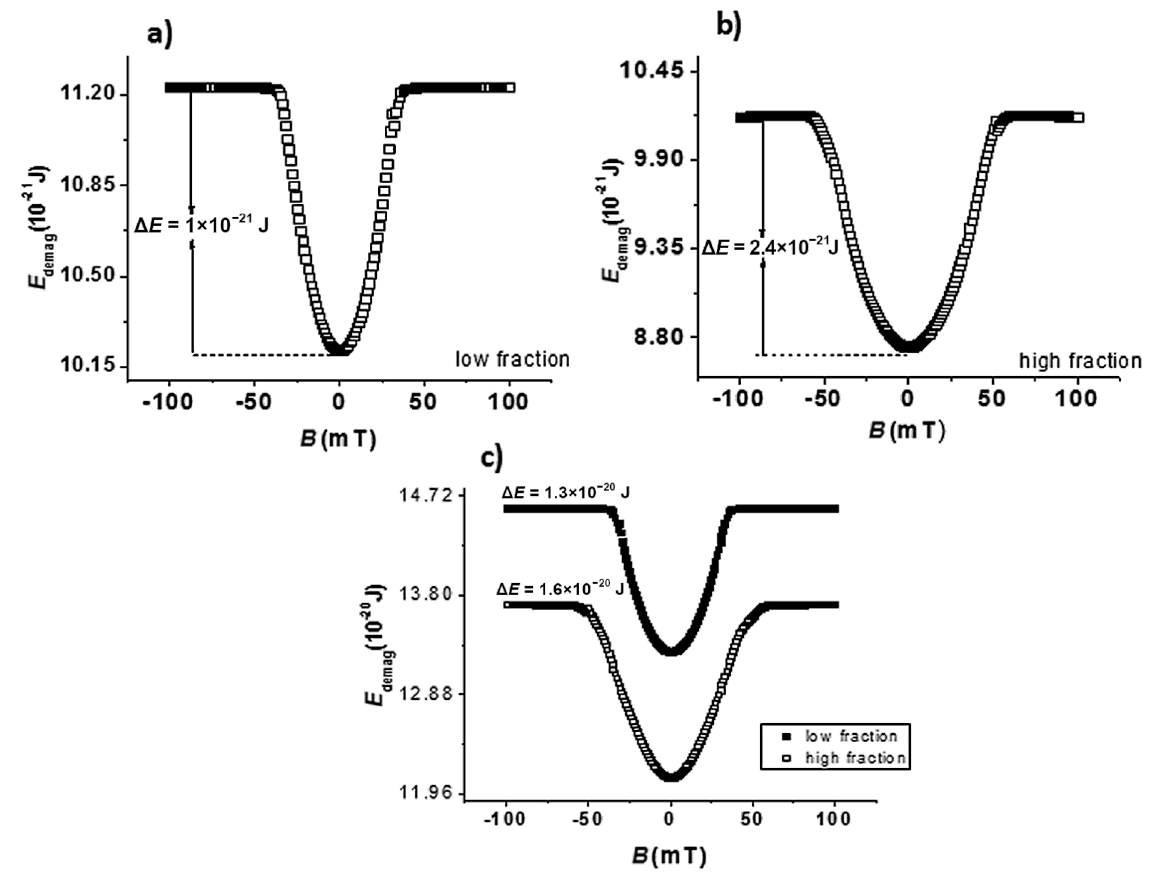
Figure 3: Demagnetization energy profiles and anisotropy energy barriers for MNP P1, for low and high volume fractions, respectively (a and b) and for the whole considered nanoparticulate system for the same configurations (c).